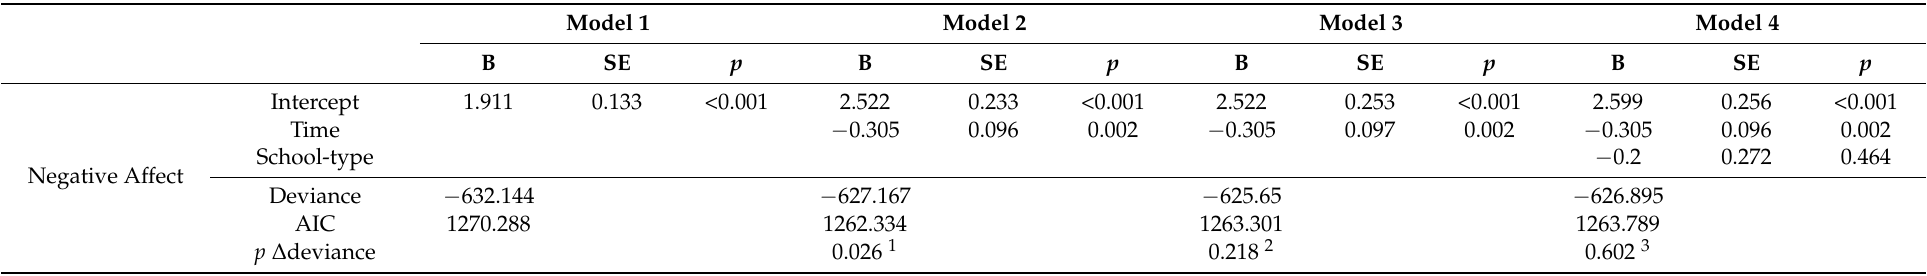
Table 3. Unstandardized coefficients and model fit indices for the four multilevel models predicting negative affect. Model 1 = intercept only, Model 2 = random intercept for time, Model 3 = random intercept and slope for time, Model 4 = random intercept for time. Level 1 = time, level 2 is student.